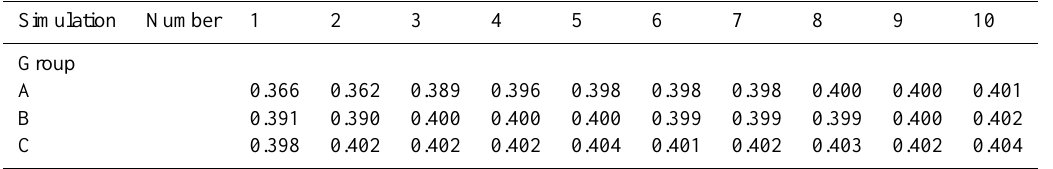
Table 4. Spillover ratio values for all RAMS sensitivity